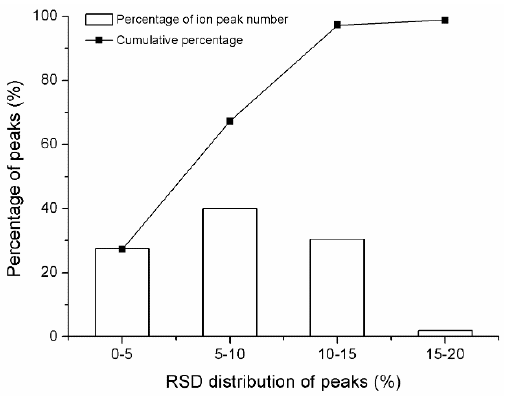
Figure 2. RSD (%) distribution of all metabolites in the pooled quality control (QC) samples.